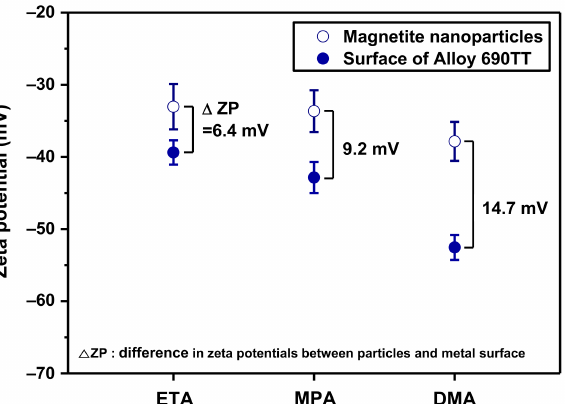
Figure 14. Zeta potentials at 25 ◦ C of the surface of Alloy 690TT plate and magnetite nanoparticles depending on which of the three advanced amines was used.